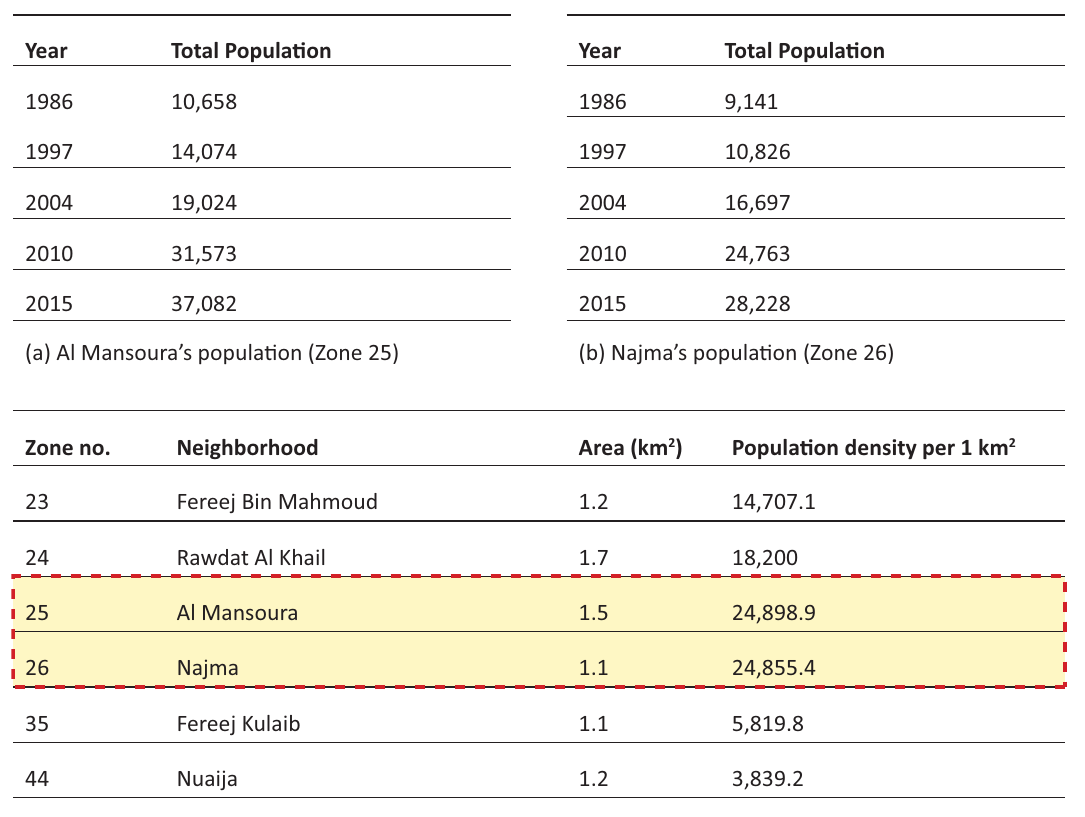
Figure 4. Al Mansoura’s and Najma’s population and population density in relation to other neighborhoods of similar area. Source: Authors’ work based on Ministry of Development Planning and Statistics